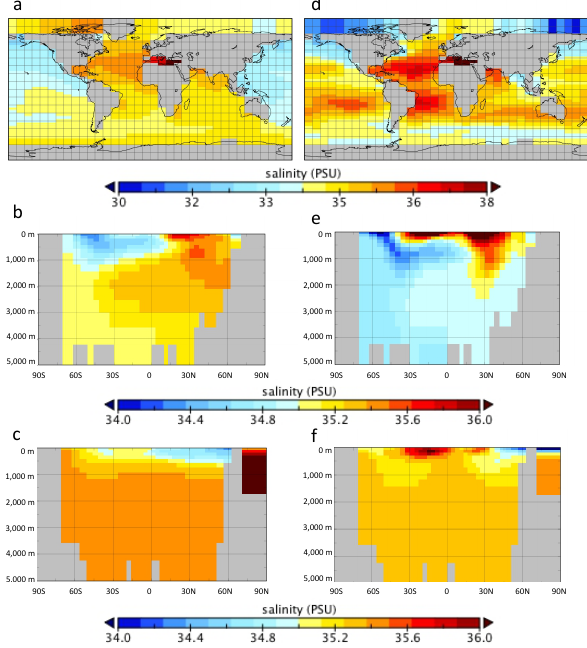
Fig. 3. Temperature: (a) , (b) and (c) EFPC ensemble averages, (d) , (e) and (f) observations (Locarnini et al., 2006). Upper panels are surface fields ( ∼ 81m depth). Middle panels are Atlantic cross sec- tions (25 ◦ W). Lower panels are Pacific cross sections (155 ◦ W).